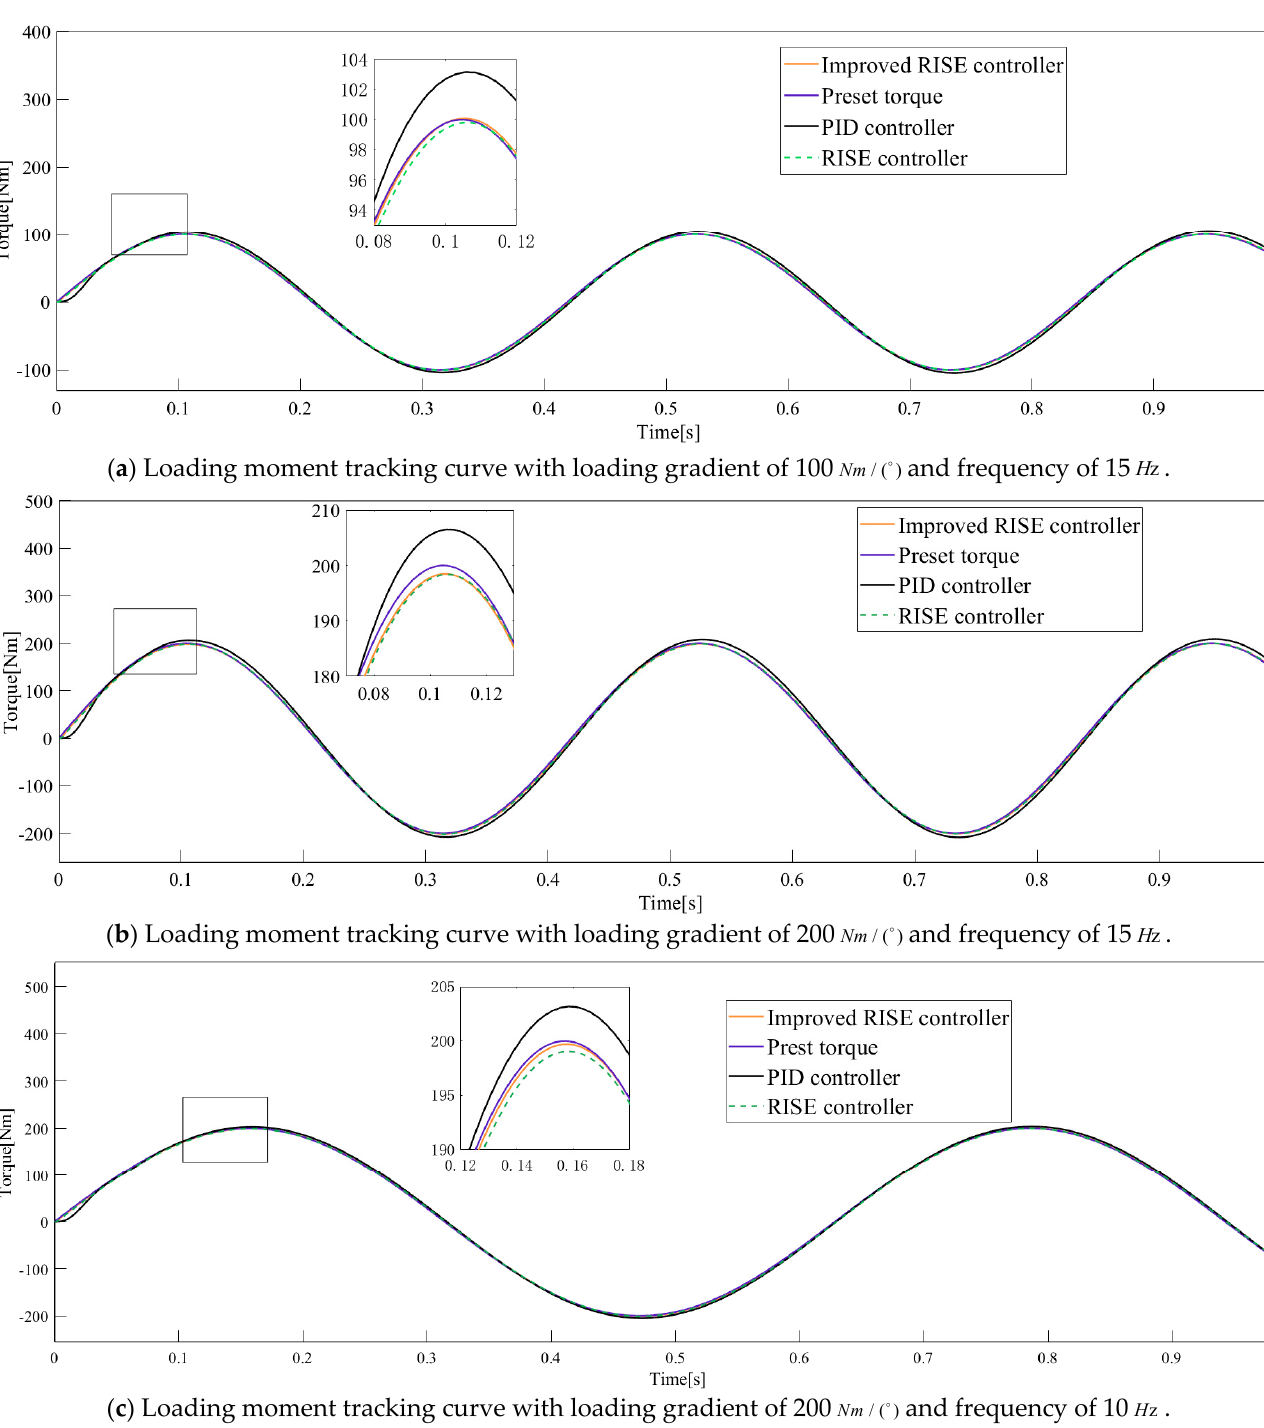
Figure 8. Command torque tracking effect.